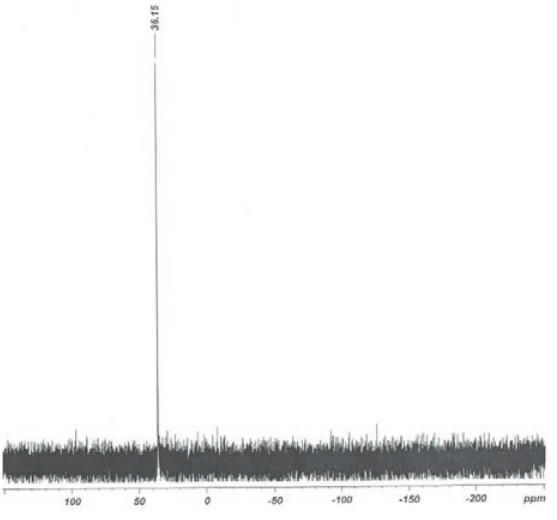
Figure 3. 31 P NMR spectrum of [Ru(CO)(PPh